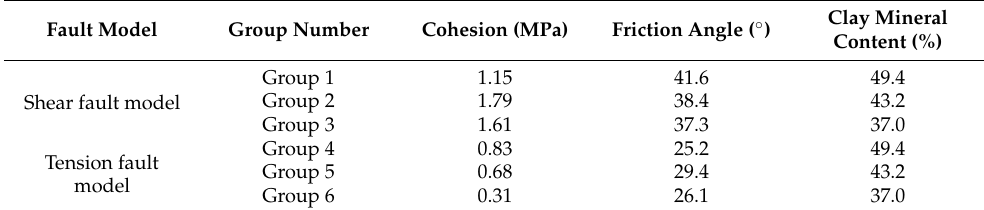
Table 4. Cohesion and friction angle obtained from the direct shear tests of two types of fault rocks filled by different types of fault gouge.